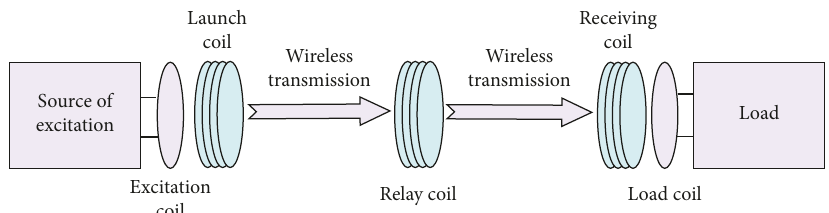
Figure 4: Schematic of the five-coil wireless energy transmission system.